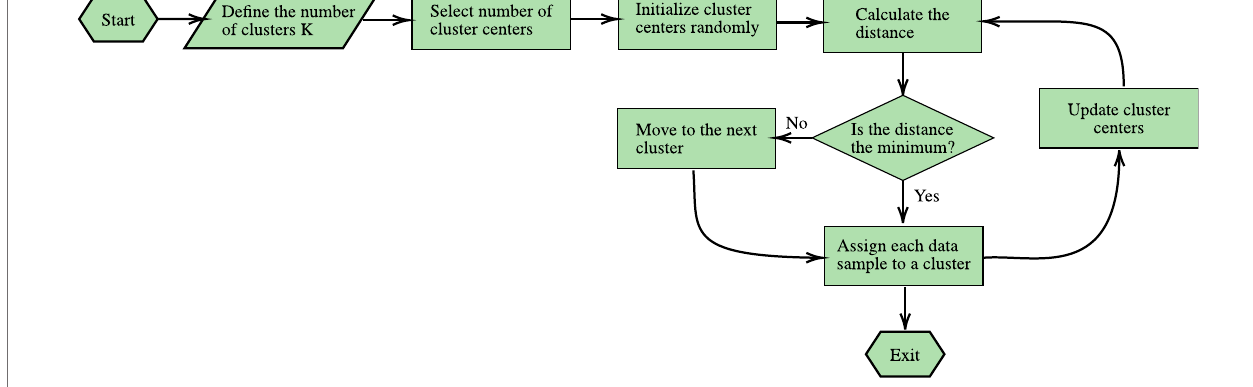
FIGURE 9 | K-means algorithm.